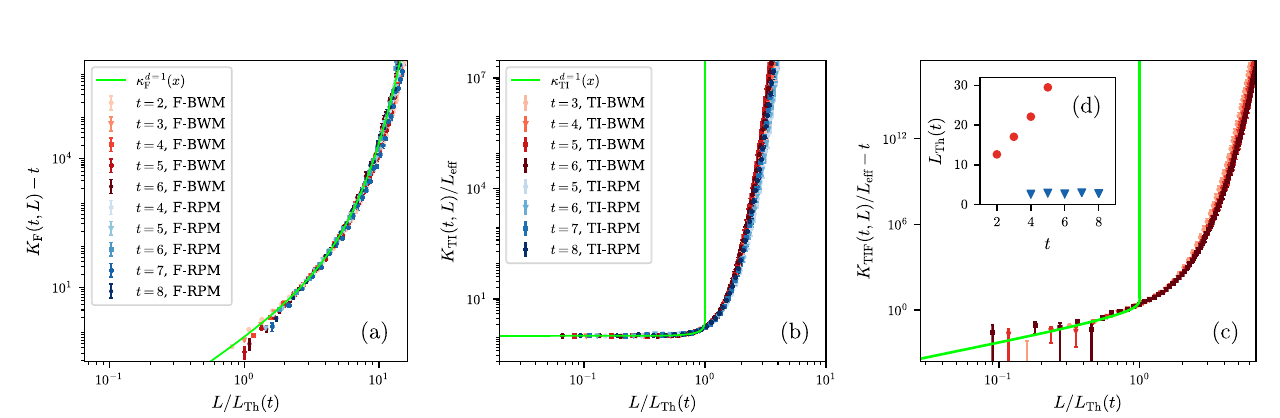
Fig. 2 | Numerical simulations of scaling forms of SFF for MBQC systems with space-time translational invariance. Scaled SFF vs. x = L / L Th at fi nite q for a FloquetRPMandBWM, b TIRPMandBWM(middle),and c TIFloquetBWM;inall panelstheRPMhas q =3,whiletheBWMhas q =2in a , b ,and q =3in c .Thein fi nite-